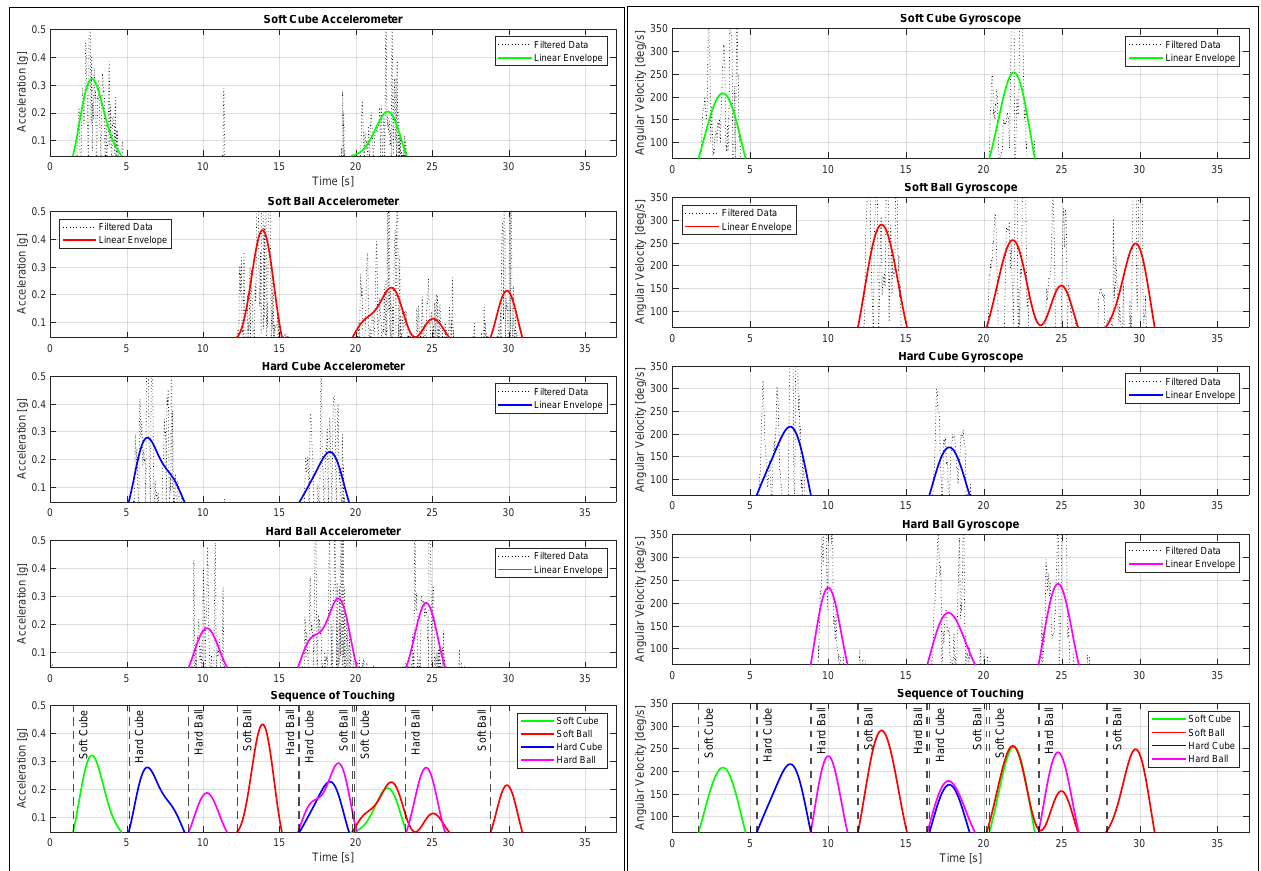
Figure 12. Accelerometer and gyroscope data indicating the sequence of touches. To quantify the accuracy of the IMU results, we computed the timing error and root mean squared error (RMSE) (Table 4). The accelerometer tended to estimate the touch time to be earlier than it was and had an RMSE of 0.32 s, and the gyroscope did a better job at estimating the touch timing with an RMSE of 0.23 s. We could further improve the IMU- based touch detection accuracy by taking the average touch time from the accelerometer and gyroscope, resulting in an RMSE of just 0.19